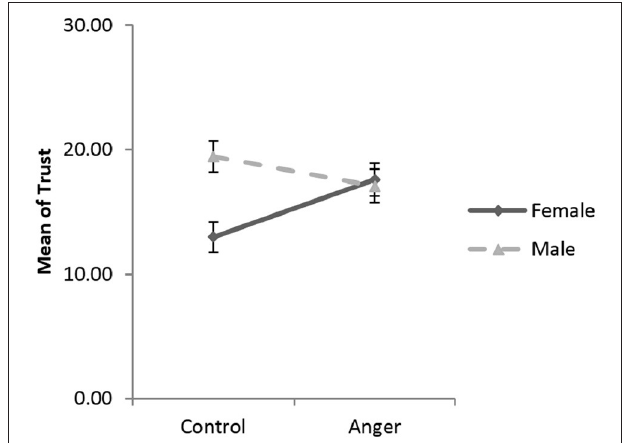
FIGURE 3 | Estimated marginal means of trust (in point) in the anger and control conditions in Study 1. Error bar is the standard error.